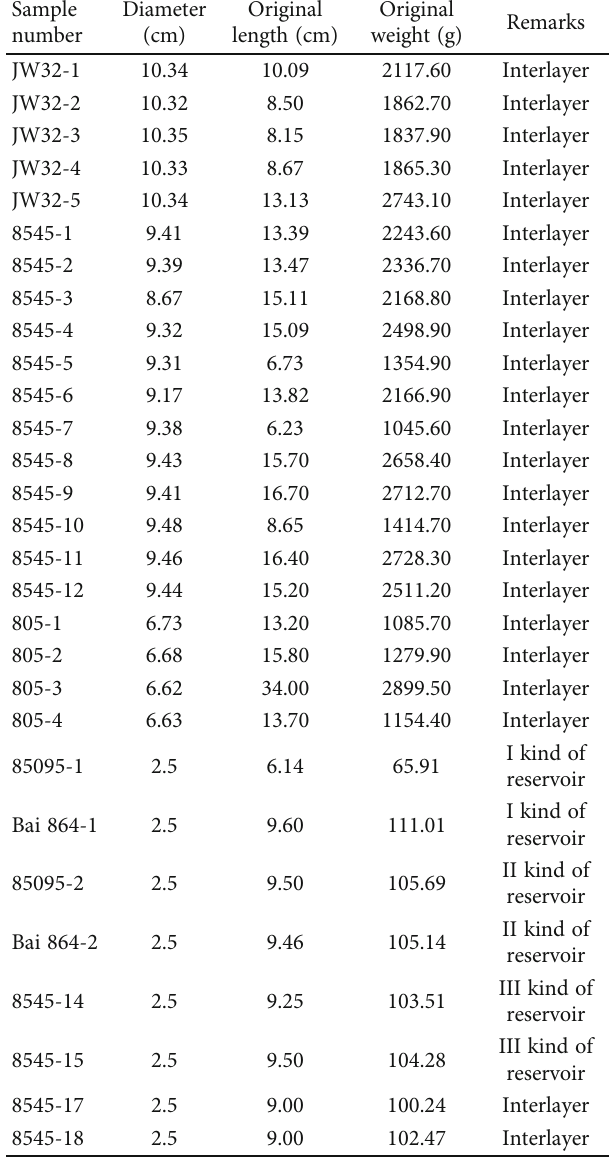
Table 1: Basic information of full-diameter rock